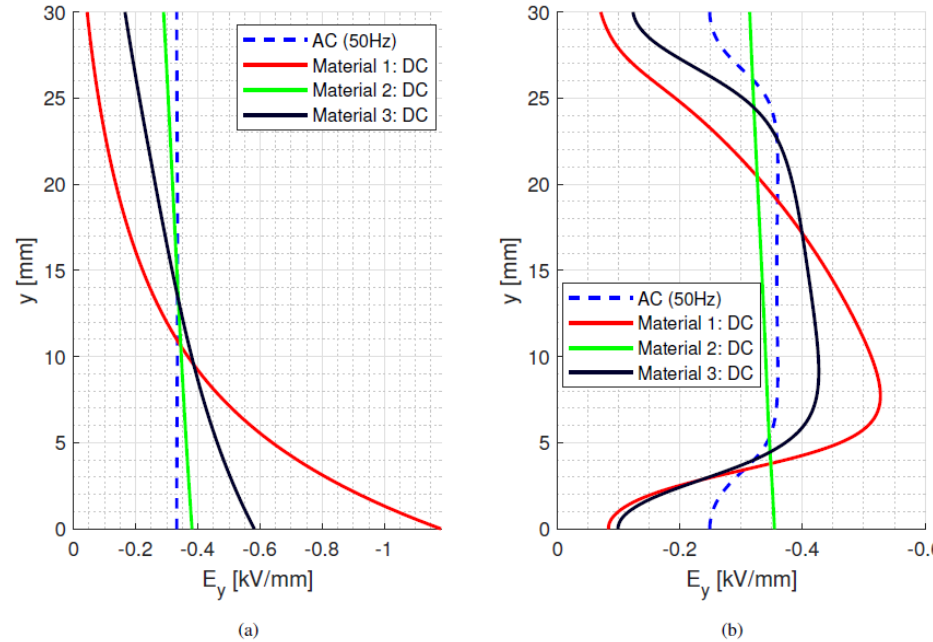
Figure 9. ( a ) Orthogonal bulk and ( b ) surface tangential field (Ey) for ac and dc steady state, with a temperature gradient of 20 °C (high-potential electrode warm, Figure 1a). Material characteristics of Table 2.